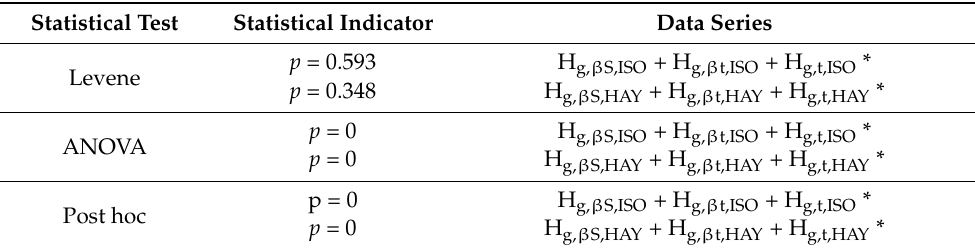
Table 3. One-way ANOVA applied to the H g,ISO or the H g,HAY data series for Saudi Arabia in the period 2005–2016 under the 3 solar system configuration modes in all-sky conditions. df = degrees of freedom, p = probability. The confidence interval is 95% ( α = 0.05).